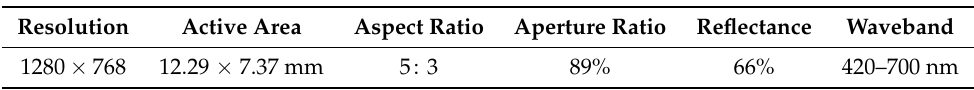
Table 1. Parameter list of the iquid crystal on silicon (LCoS), which is used as the lighting modulator in the